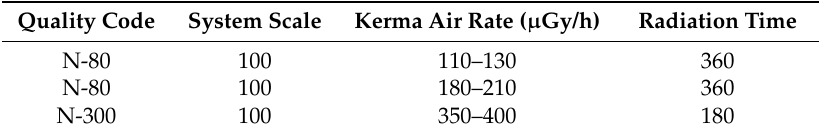
Table 6. Verification procedure for N-80 and N-300 Qualities.